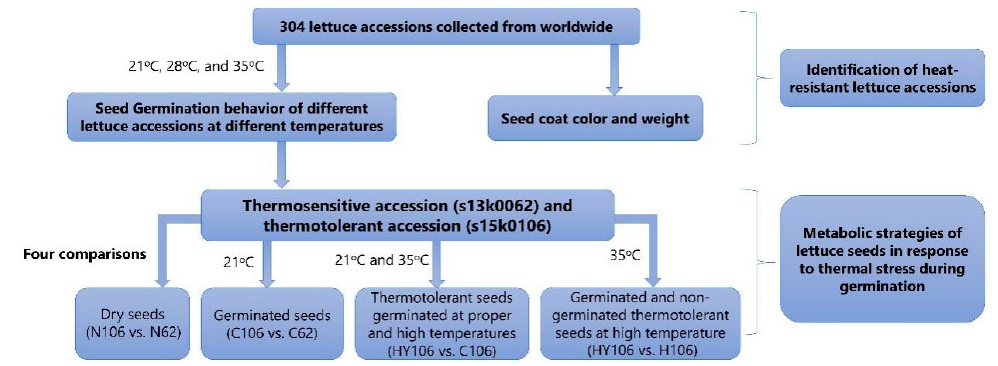
Figure 6. The workflow of the current study.